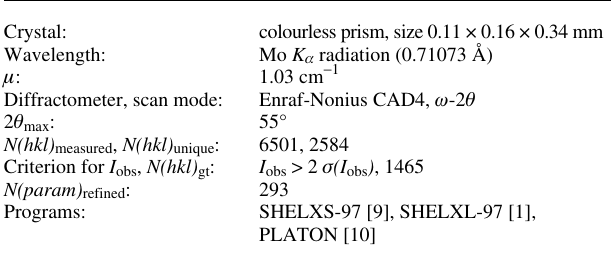
Table 1. Data collection and handling.